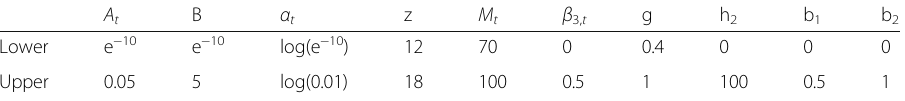
Table 3 Bounds for the parameters required for the calibration of the model